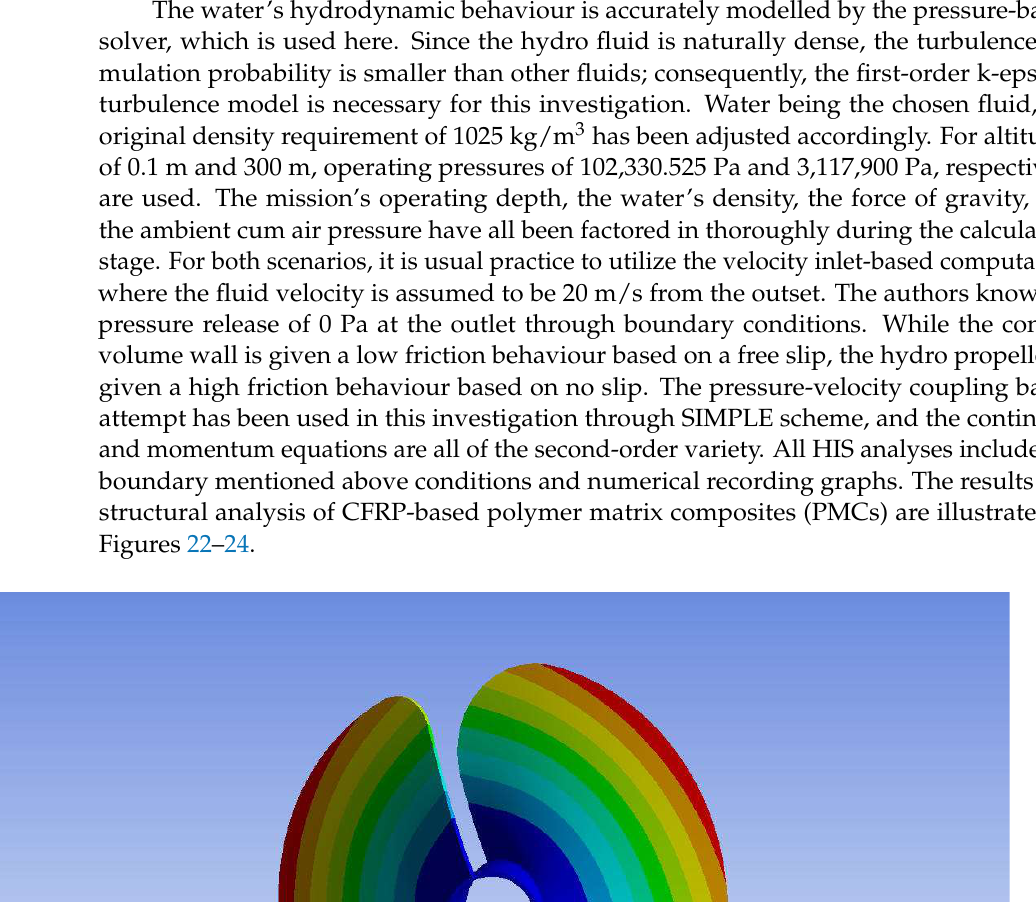
Figure 23. Normal Stress variation at 300 m depth with 20 m/s fluid velocity- CFRP002DPrepreg-Wn-230-GPa.